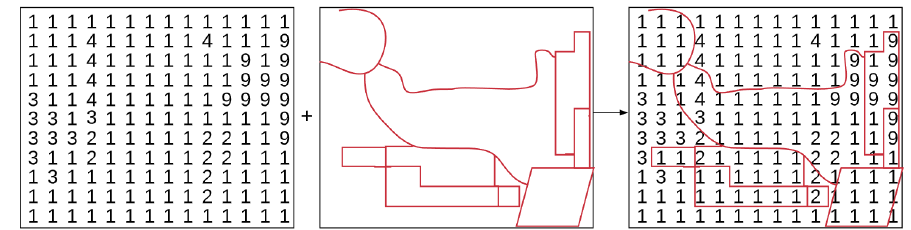
Figure 4. Principal component analysis (PCA) and segmentation map embedding